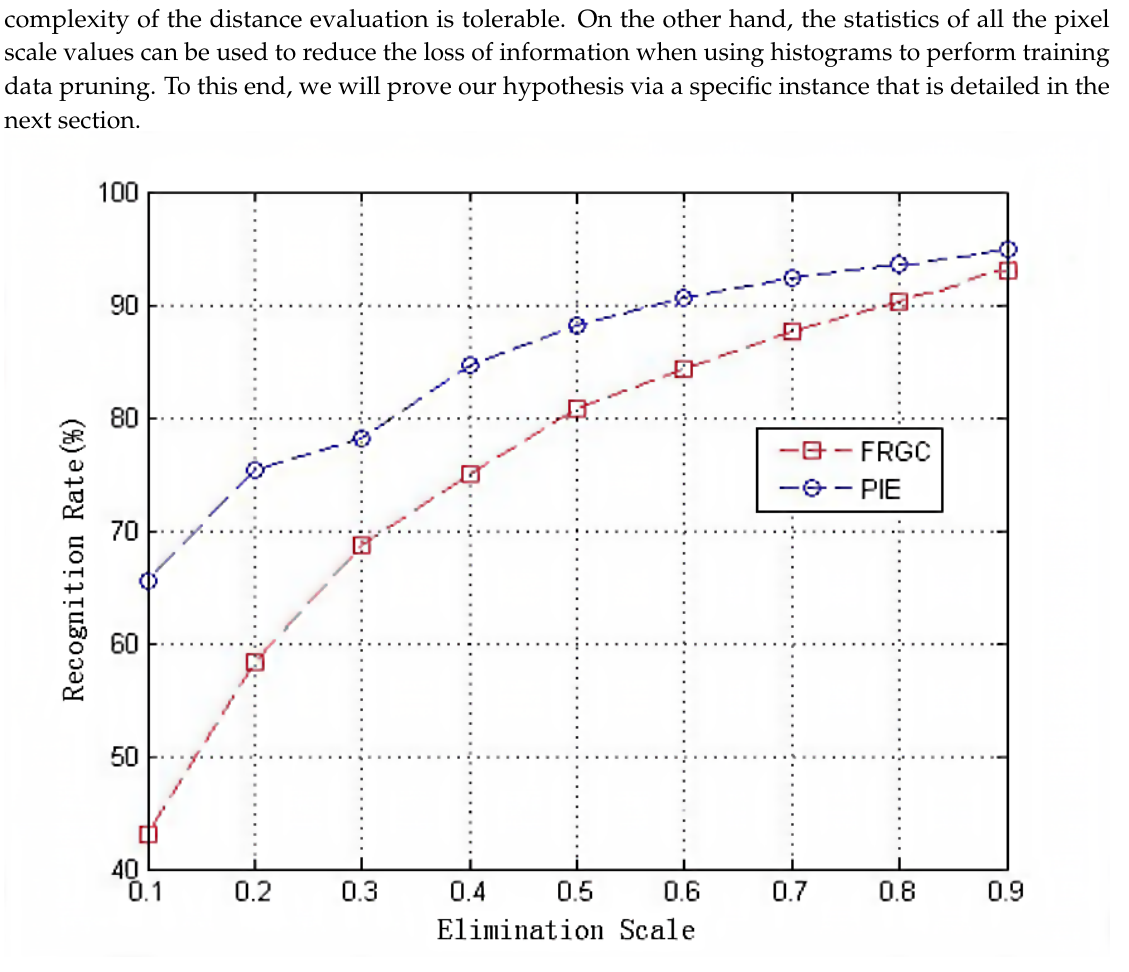
Figure 7. Classification results with different elimination scales of the training